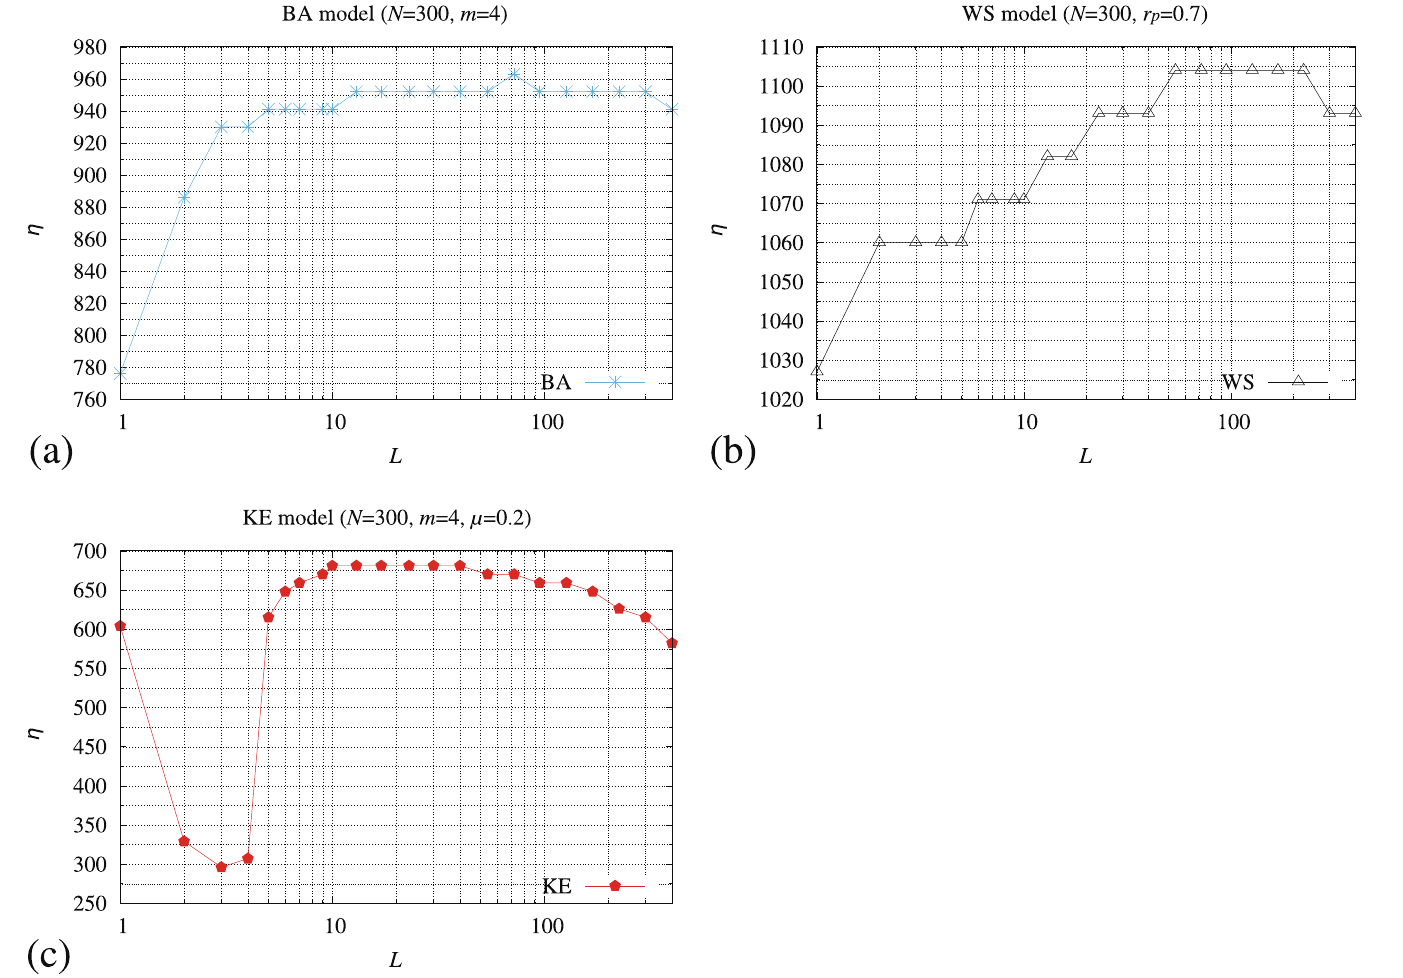
Fig 6. Relationship between a period of iterations for calculating the transmitting probability ( L ) in Eq (19) and the maximum value of R , where A in Eq (7) is lower than or equal to 0.9 of the memory-pfix method ( η ) for the (a) BA, (b) WS, and (c) KE models.